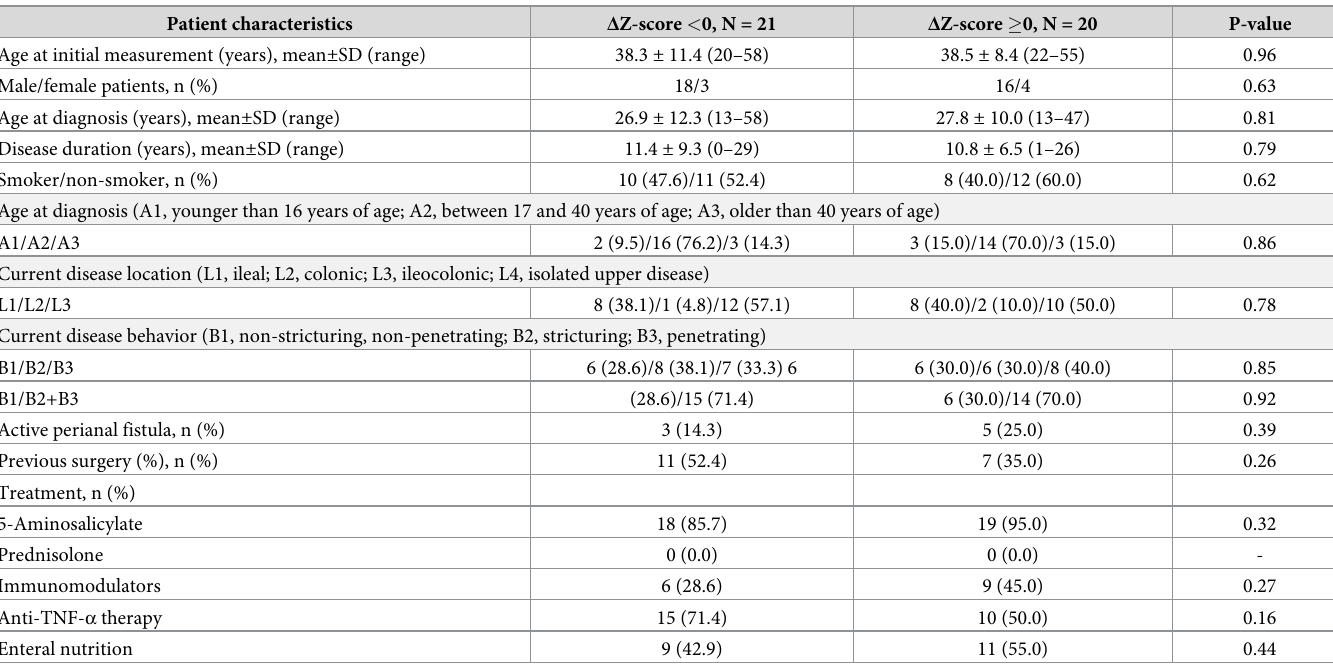
Table 2. Comparison of patient characteristics between those with an Δ Z-score < 0 and those with an Δ Z-score � 0. Patient characteristics